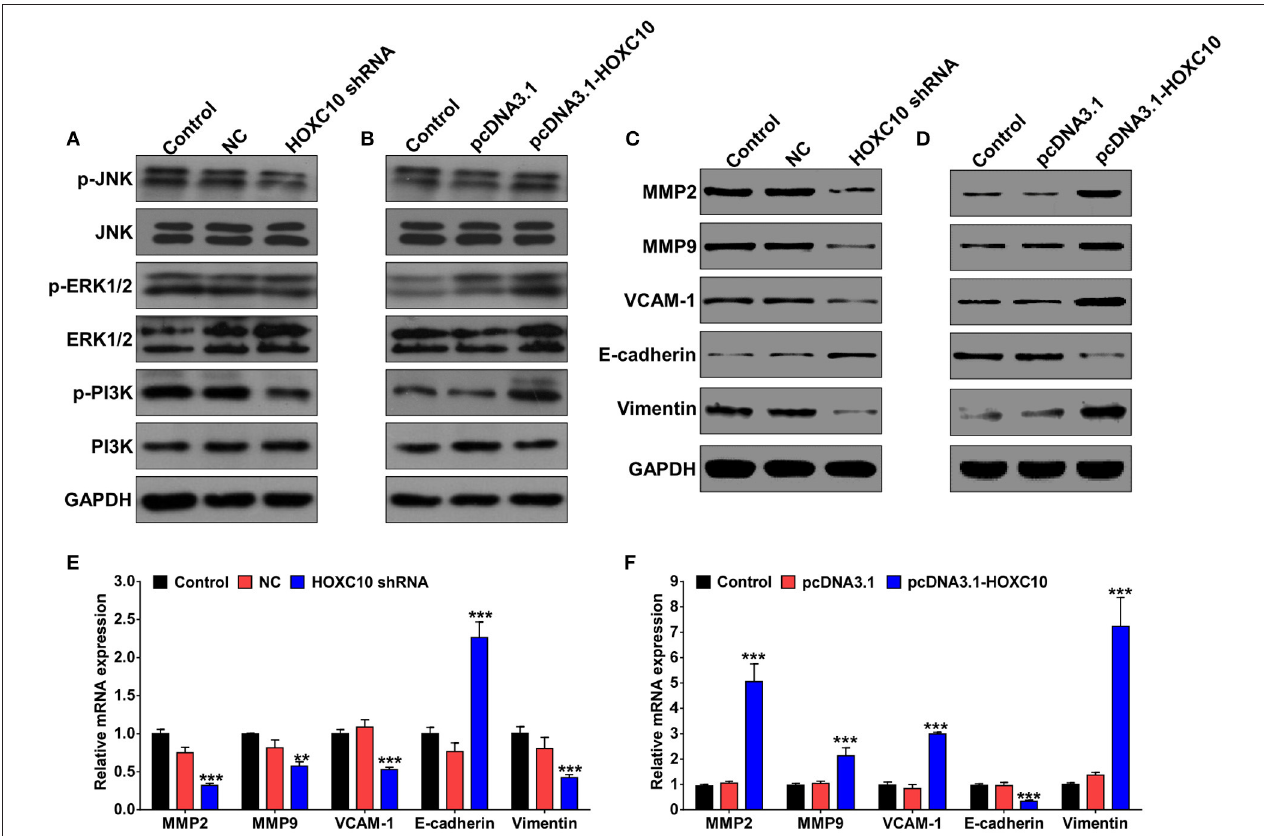
FIGURE 5 | HOXC10 regulates expression of metastasis-related proteins in lung cancer cells. H1975 cells and H460 cells were transfected with indicated shRNA or plasmid, respectively. Forty eight hour later, western blotting analysis was performed to detect p-PI3K, PI3K, p-JNK, JNK, p-ERK1/2, ERK1/2, MMP-2/9, VCAM-1, vimentin, and E-cadherin expression in H1975 cells (A,C) and H460 cells (B,D) . mRNA expression of MMP-2/9, VCAM-1, vimentin and E-cadherin in H1975 cells (E) and H460 cells (F) was evaluated by qRT-PCR. GAPDH was used as internal control. Control, untreated cells; NC, scramble shRNA control. Data are presented as means ± SD , n = 3, ** p < 0.01; *** p <